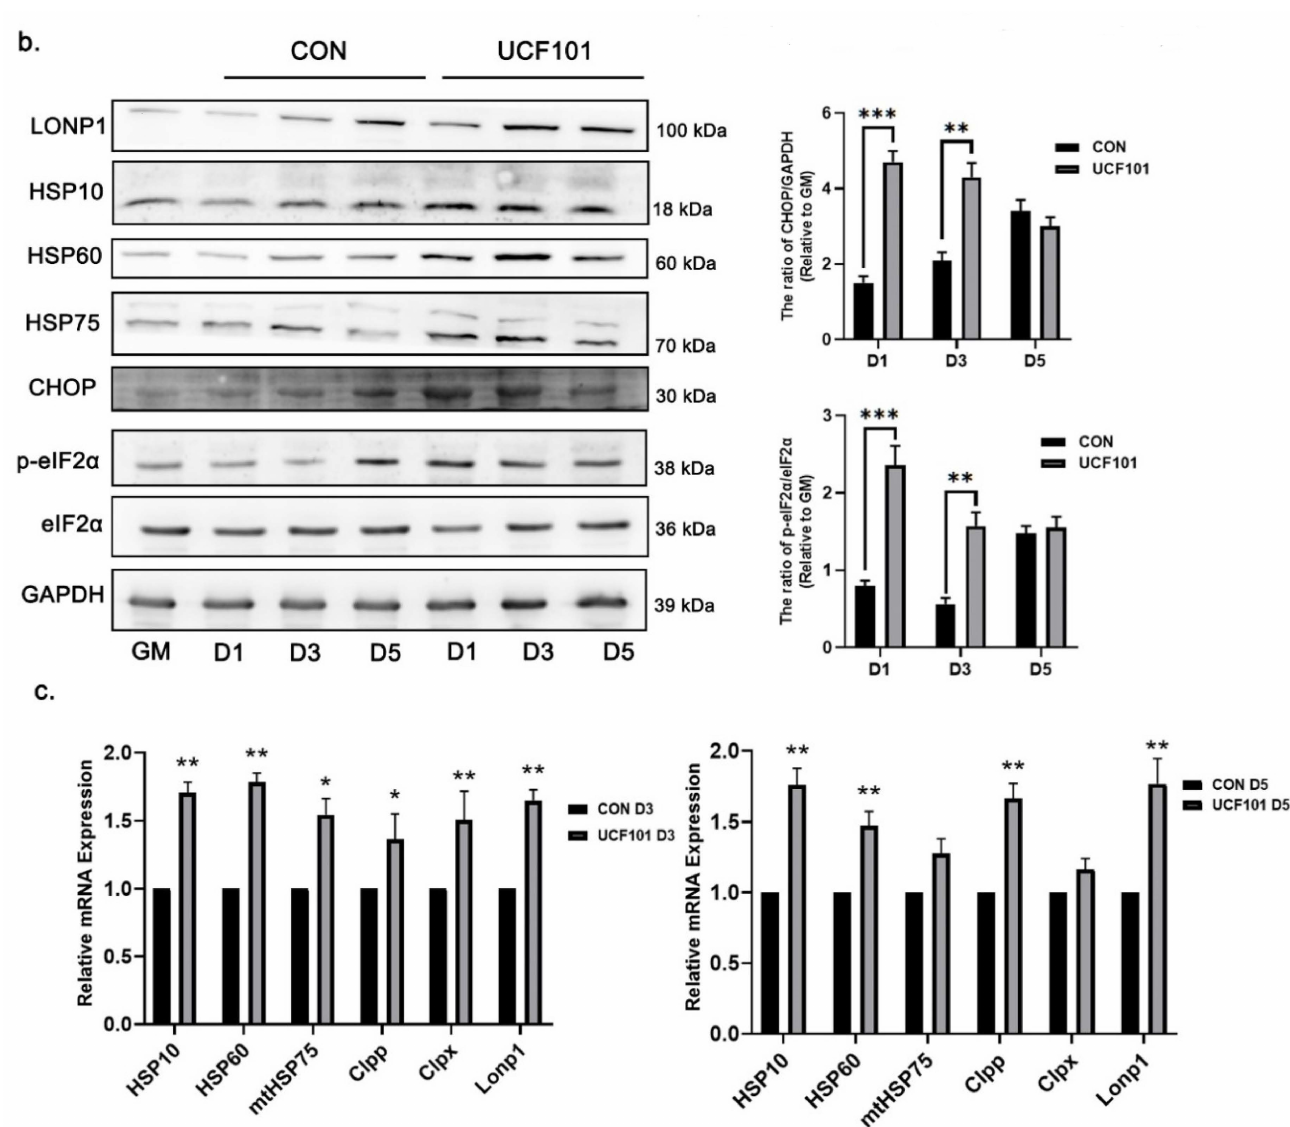
Figure 7. HtrA2/Omi protease deficiency activates UPRmt signaling during myogenic differentiation. ( a ) Western blot of IMS proteases OMA1, YME1L1, and HtrA2 on D1, D3, and D5 treated with UCF101 (20 µ M) or untreated and quantification of western blots relative to GM ( n = 3). ( b,c ) Western blot of protein expression and mRNA transcript levels of the UPRmt upstream signals CHOP, eIF2 α (and its phosphorylation), related molecular chaperones HSP10, 60, and 75, and matrix protease LONP1 at D1, D3, and D5 in C2C12 myoblasts treated with UCF101 (20 µ M) or untreated, and quantification of WB assays of CHOP and p-eIF2 α relative to GM ( n = 3). LONP1, lon peptidase 1; CHOP (Ddit3), DNA-damage-inducible transcript 3; HSP, heat shock protein; eIF2 α , eukaryotic translation initiation factor 2 subunit alpha; UPRmt, mitochondrial unfold protein response; Clpx, caseinolytic mitochondrial matrix peptidase chaperone subunit X; Clpp, aseinolytic mitochondrial matrix peptidase proteolytic subunit. Student’s t -tests were used. Statistical significance: * p ≤ 0.05, ** p ≤ 0.01, *** p ≤